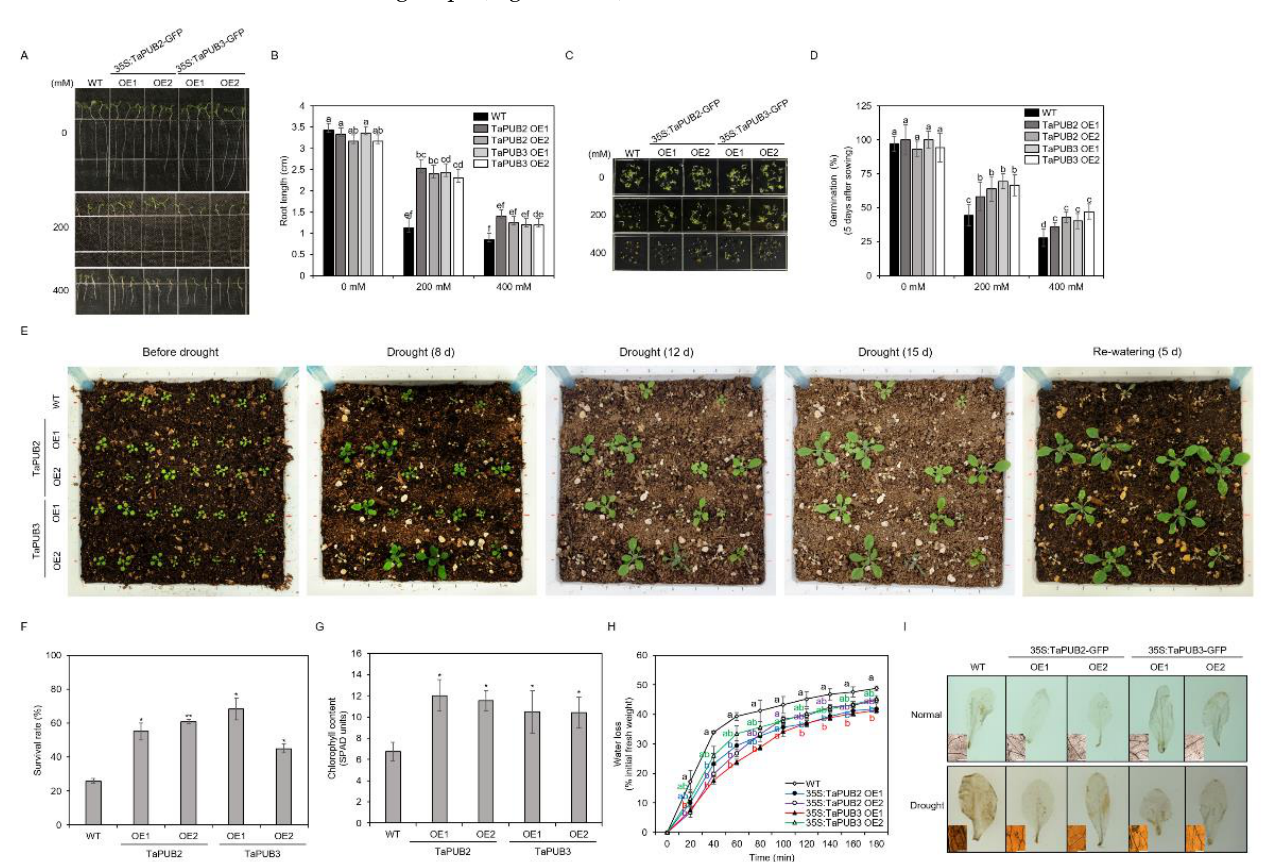
Figure 6. Phenotypes of WT and 35S:TaPUB2 and 35S:TaPUB3 overexpression plants in response to drought treatment. ( A , B ) Root length of the indicated genotypes. Four-day-old seedlings were transferred from 1/2 MS to 1/2 MS medium previously infused with different concentrations of mannitol (200 and 400 mM). Photographs were taken 4 days after the transfer. ( C , D ) Germination rate of TaPUB2 - and TaPUB3 -overexpressing plants in MS and mannitol (200, 400 mM)-containing MS media. ( E ) TaPUB2 , TaPUB3, and WT grown under drought stress. After planting in soil, seedlings were not watered for 2 weeks and then re-watered for 1 week. ( F ) Survival rates (%) under drought conditions were determined as the number of visibly green plants after rehydration. ( G ) Total chlorophyll content was measured in WT and overexpressing plants after recovery. ( H ) Comparison of the rate of water loss from detached rosettes between WT and overexpressing plants. ( I ) H 2 O 2 content in Arabidopsis under normal conditions and drought treatment, with 3,3-diaminobenzidine staining assay of rosette leaves of WT and TaPUB2 and TaPUB3 -overexpressing lines. Values are mean ± SD, n = 3. * Indicates significant difference between TaPUB2 or TaPUB3 plants and WT control based on the ANOVA (* 0.01 ≤ p < 0.05, ** p < 0.01), using the Duncan’s multiple range test (DMRT). Different letters indicate significant differences ( p -value 0.05) among the genotypes under the same treatment.